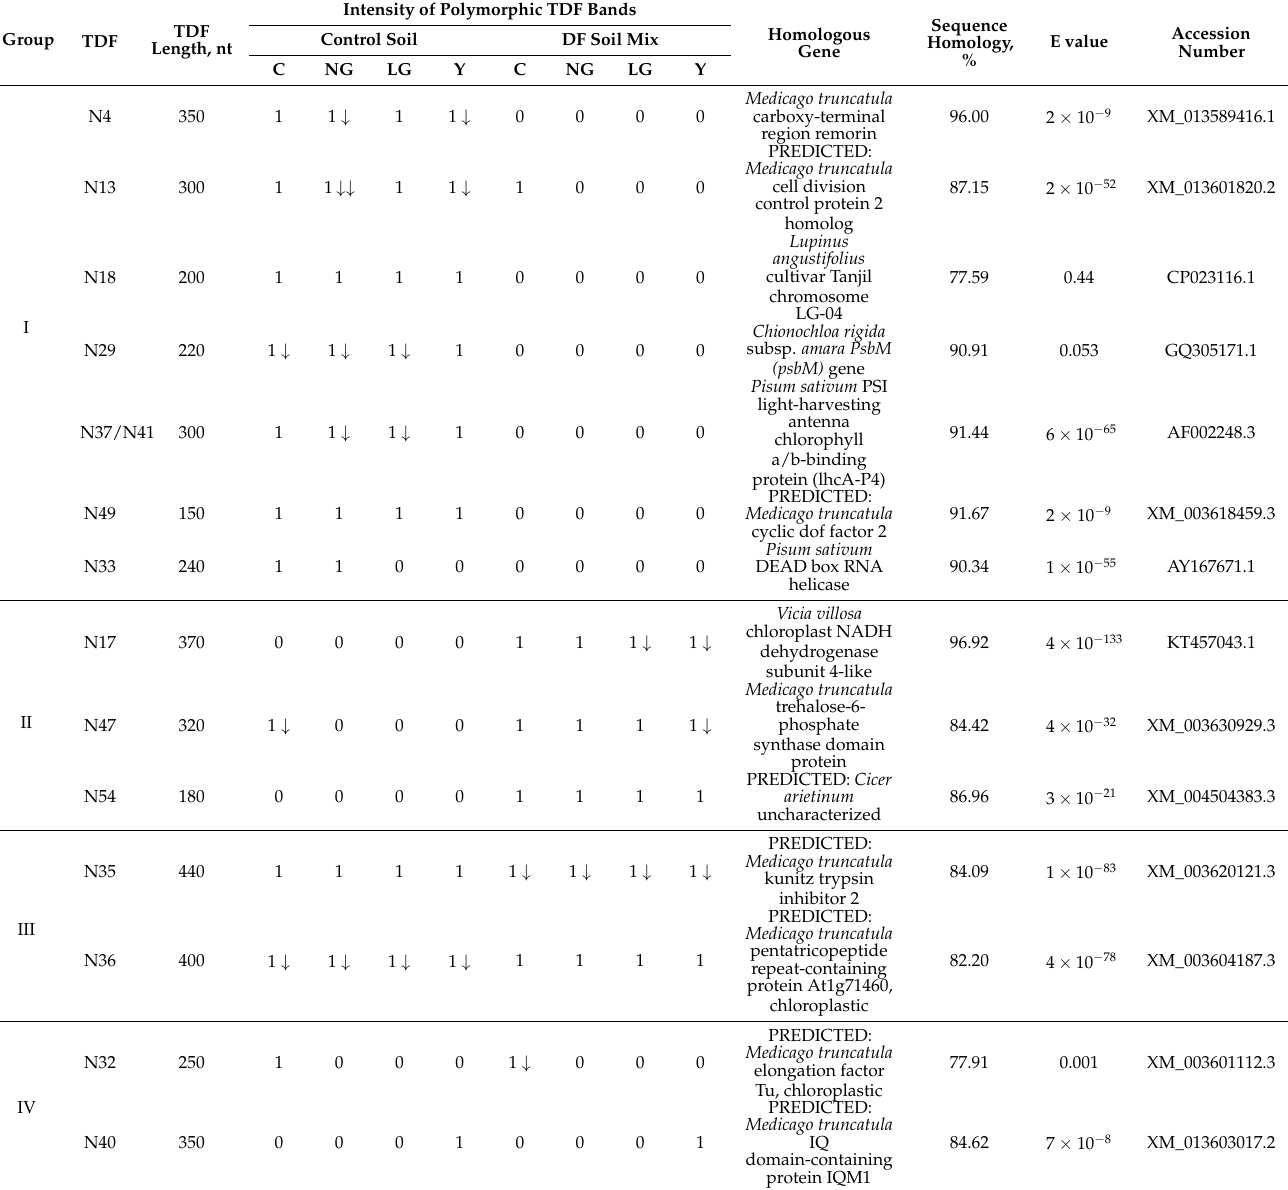
Table 2. Polymorphic transcript-derived fragments (TDFs) detected in Co-treated and untreated Vicia faba plants after one month of growth in control soil and polluted soil mix from the territory of the former drill factory